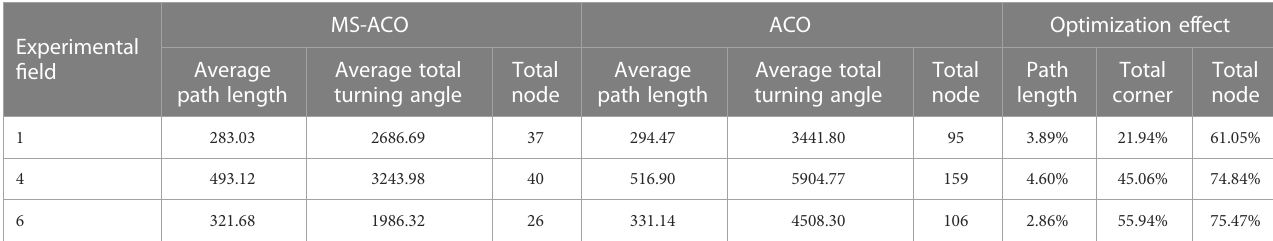
Experimental fi